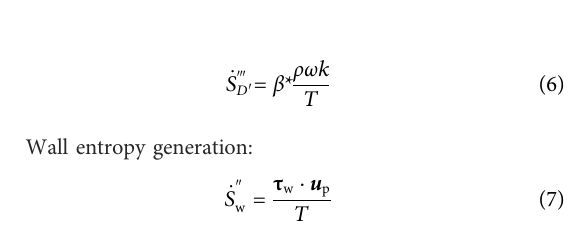
FIGURE 7 3D drawing of impeller before and after optimization.